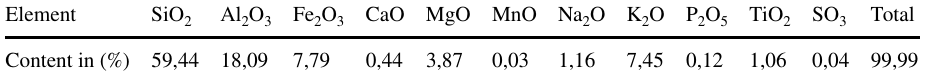
Table 5 Chemical properties of Kenadsa’s natural green clay